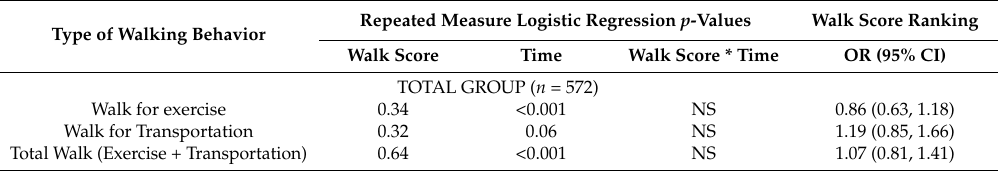
Table 3. Repeated measure mixed model logistic regression—relationship between Walk Score ® ranking and walking for exercise, walking for transportation, and total walking